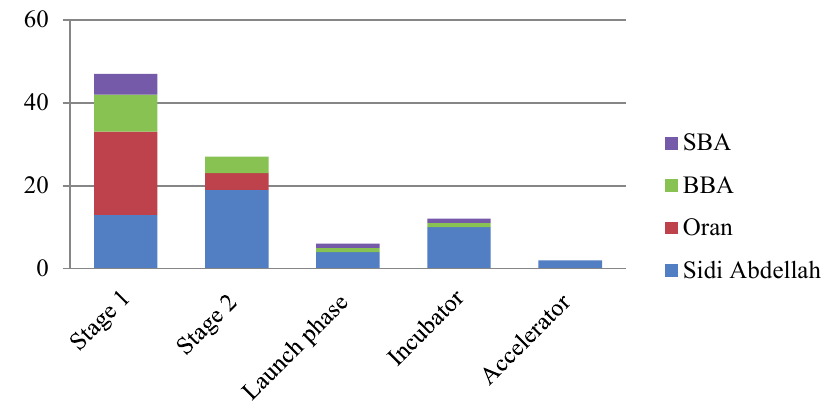
Fig. 4. Number of project leaders and start-ups per site and per support phase (image at the end of March 2020). (The author’s contributions based on the documentation provided by NATP,